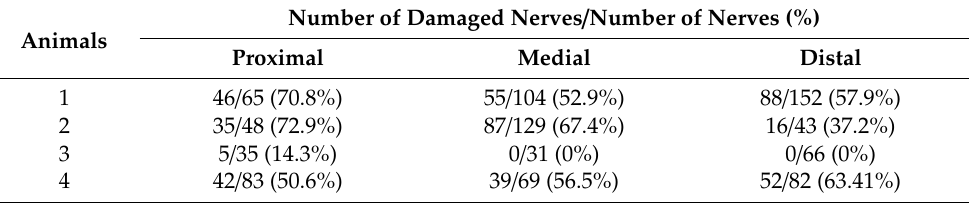
Table 1. Percentage of damaged nerves by tyrosine hydroxylase immunostaining (score ≤ 2). Number of Damaged Nerves / Number of Nerves (%) Animals Proximal Medial Distal